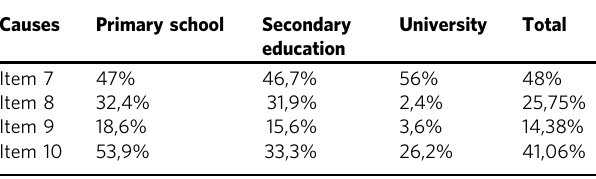
Table 2 Students ’ misleading about climate change